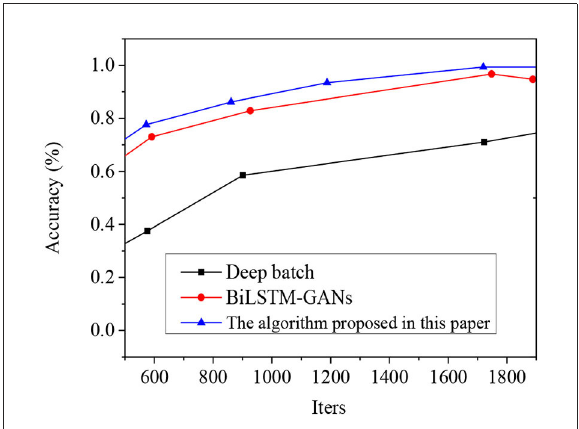
FIGURE11 Comparison of the deep Bach model, BiSTM-GAN model, and the proposed AM-IndRNN model.